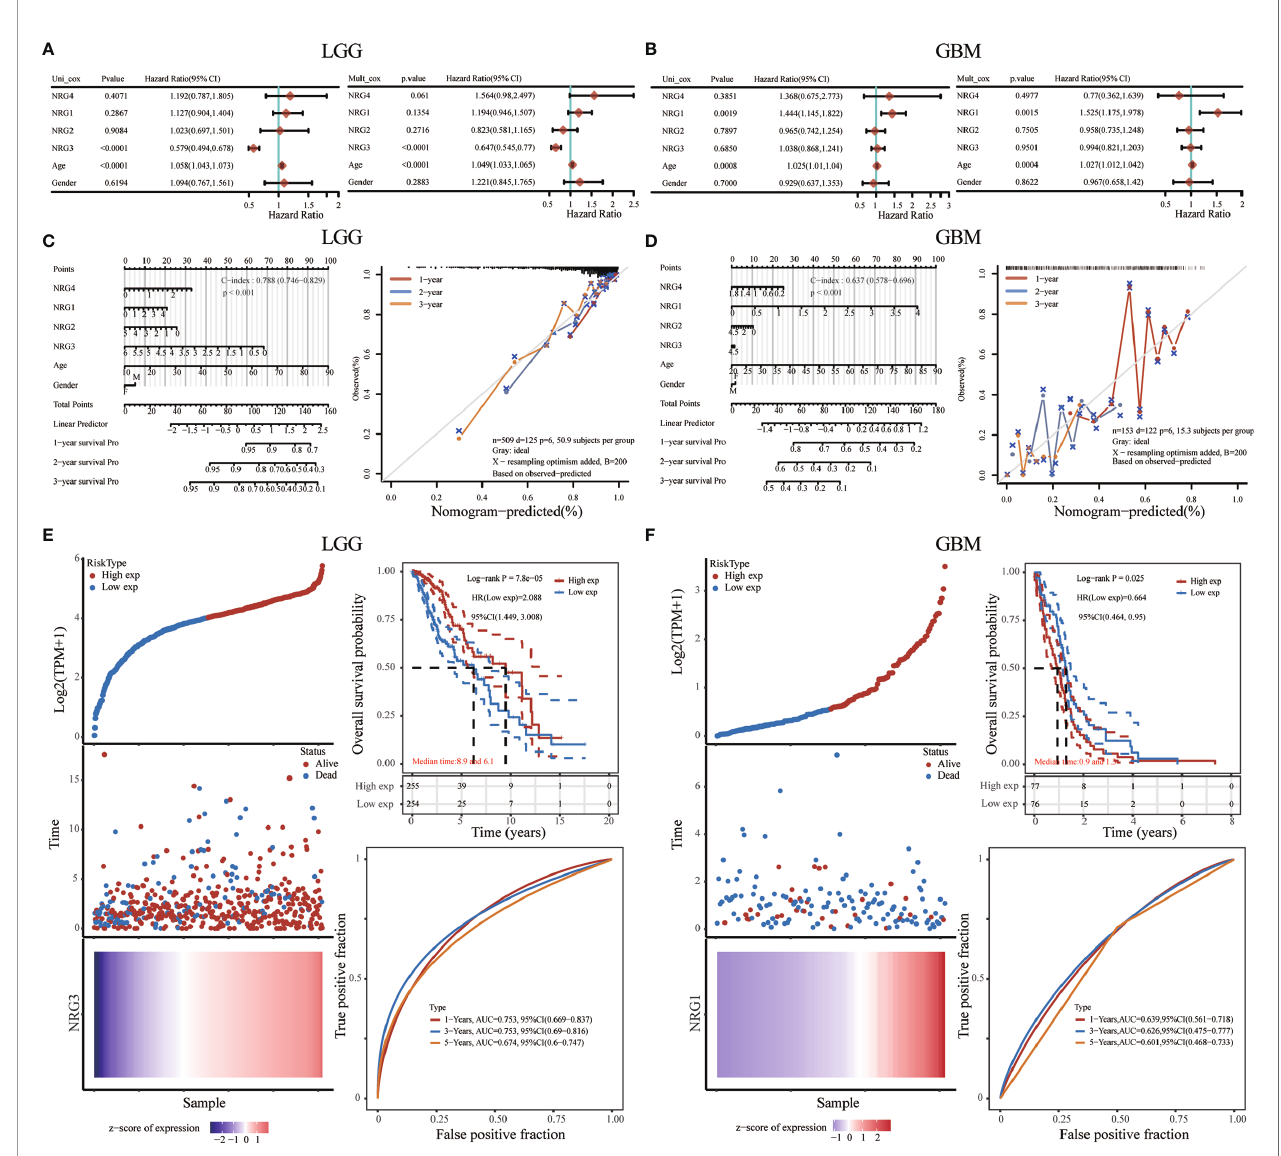
FIGURE 11 | Prognostic value of NRGs in LGG and GBM. Univariate and multivariate Cox regression of NRG1-4 in LGG (A) and GBM (B) . Nomogram to predict the 1, 2 and 3-year overall survival of patients with LGG (C) and GBM (D) . The dashed diagonal line represents the ideal nomogram, and the blue, red and orange lines represent the 1, 2 and 3-year observed nomograms, respectively. Risk model and prognostic analysis of NRG3 in LGG (E) , and NRG1 in GBM (F) , respectively. The prognostic risk model shows the Risk type (top left), patient status (middle left) and mRNA expression heatmap (bottom left), and Kaplan – Meier curves of OS (top right) and time-dependent ROC (bottom right) for NRG3 in LGG (E) and NRG1 in GBM (F)